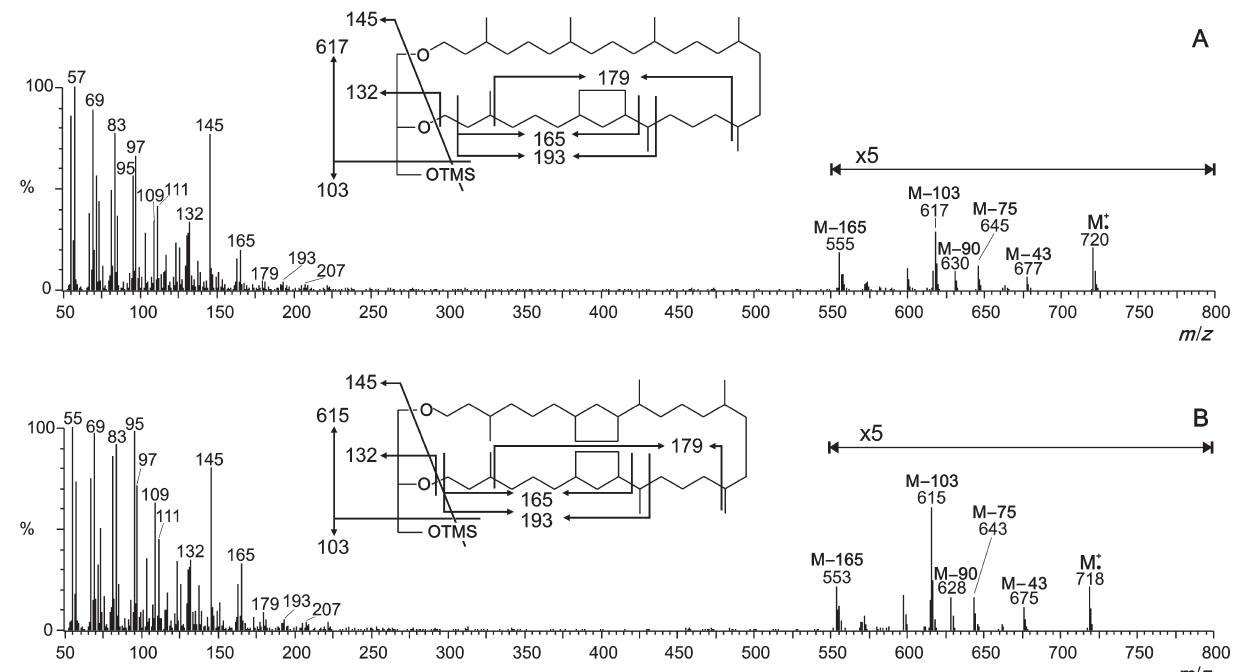
Figure 3. Mass spectra (subtracted for background) of novel macrocyclic diethers A and